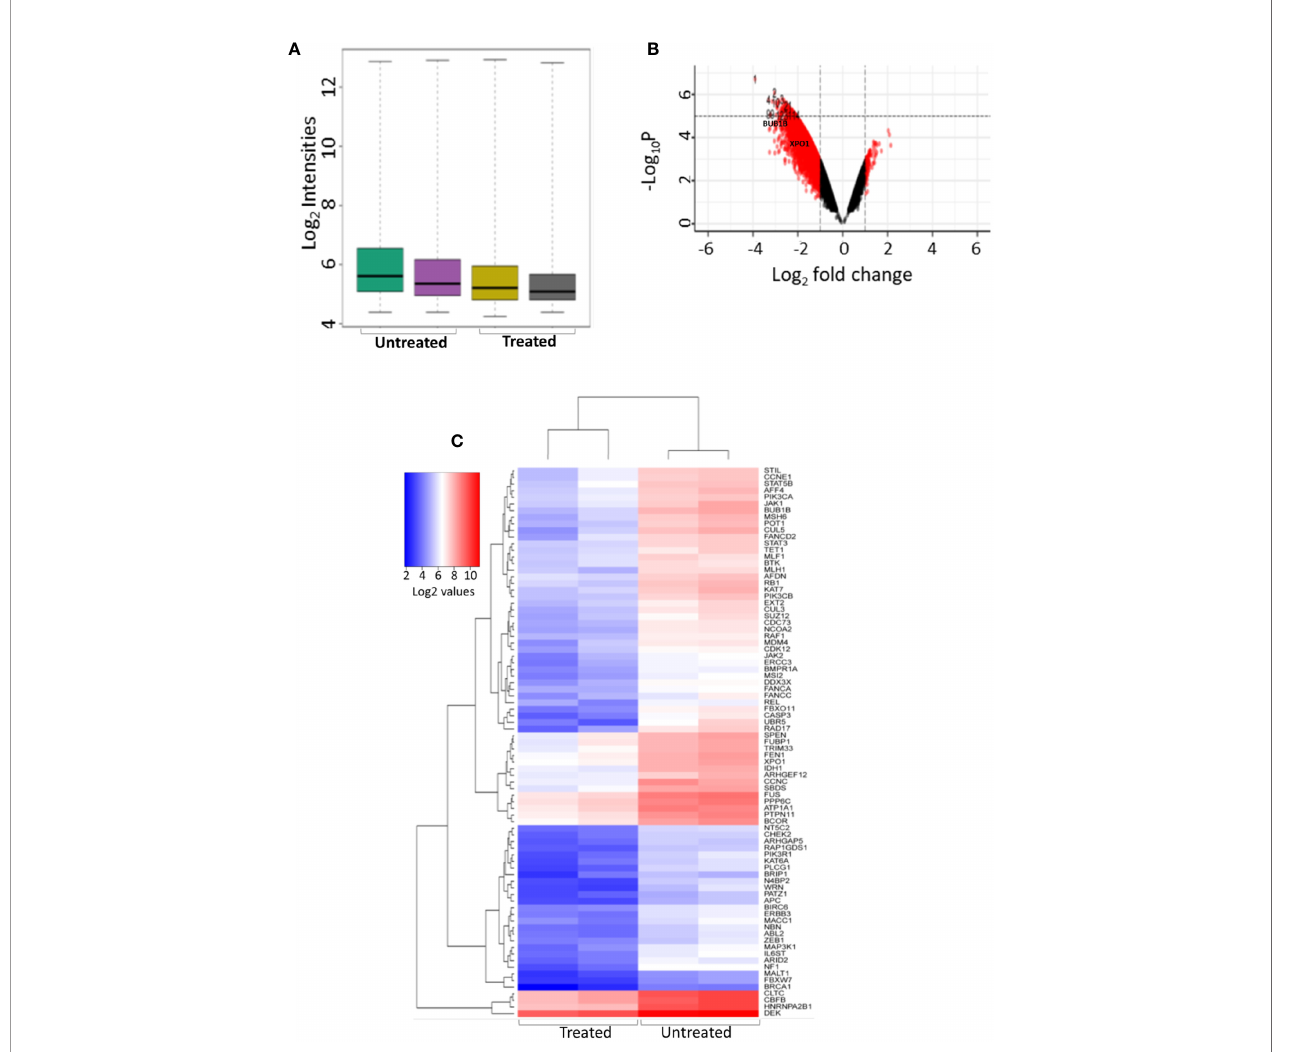
FIGURE 1 | Differential gene expression of treated and untreated K562 cell line using microarray. (A) Intensity plot displaying the quality of the microarray CELL data (B) Volcano plot showing the differentially expressed genes between K562 cell line treated with NSP-B (10µM) and untreated K652 cells, A log 2 fold change (FC) cutoff of ± 1.5 was used for signi fi cant differentially expressed genes with p < 0.05. (C) Heatmap displaying the expression of signi fi cant differentially expressed cancer genes between treated and untreated K562